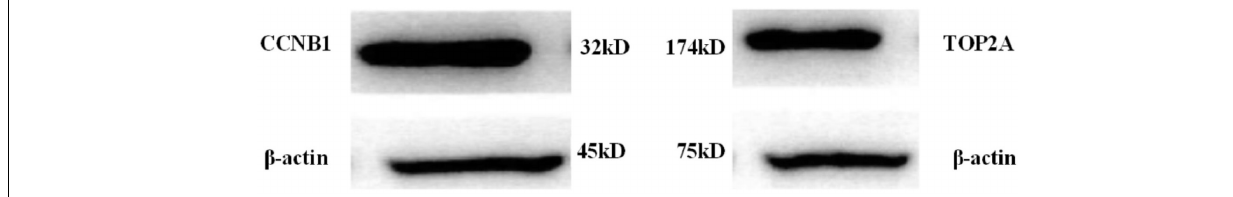
FIGURE 8 | Protein expressions of CCNB1 and TOP2A in lung cancer patients.